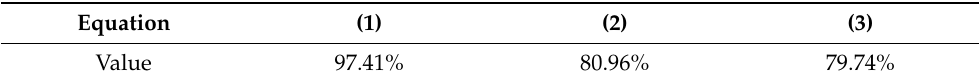
Table 2. Comparison of different values calculated with the Equations (1)–(3) based on the confusion matrix in Table 1.